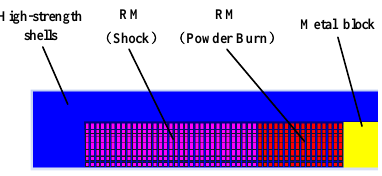
Table 2. Main materials parameter table.